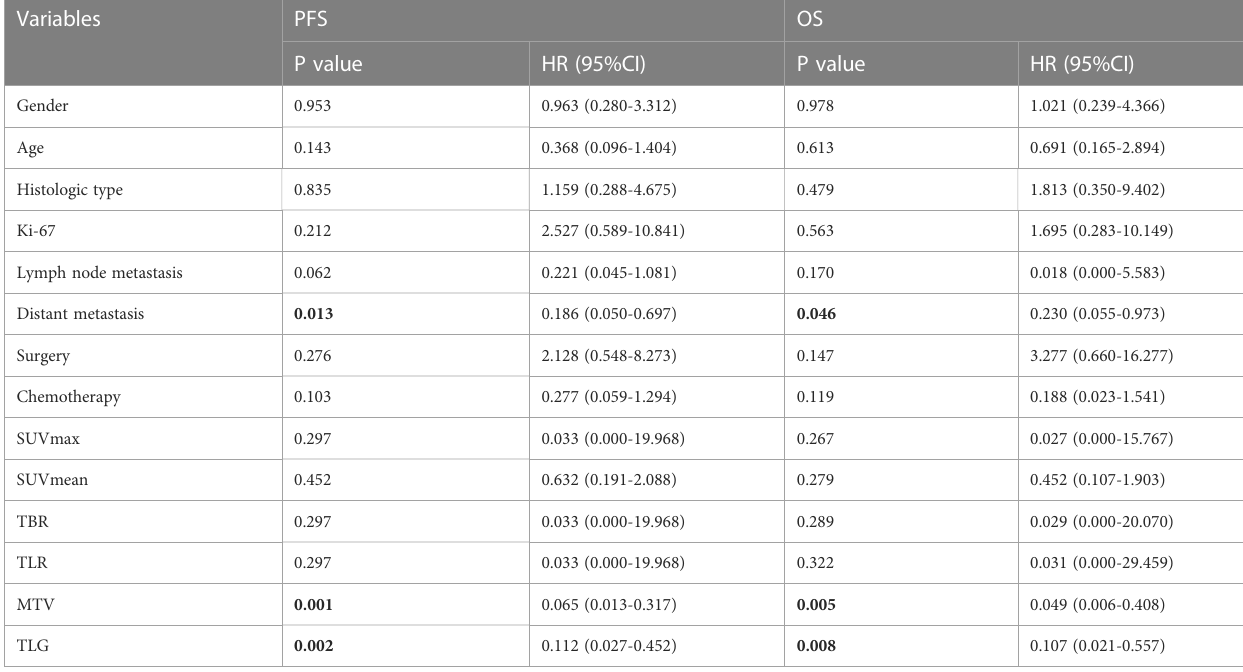
TABLE 4 Univariate analysis for progression-free survival (PFS) and overall survival (OS).